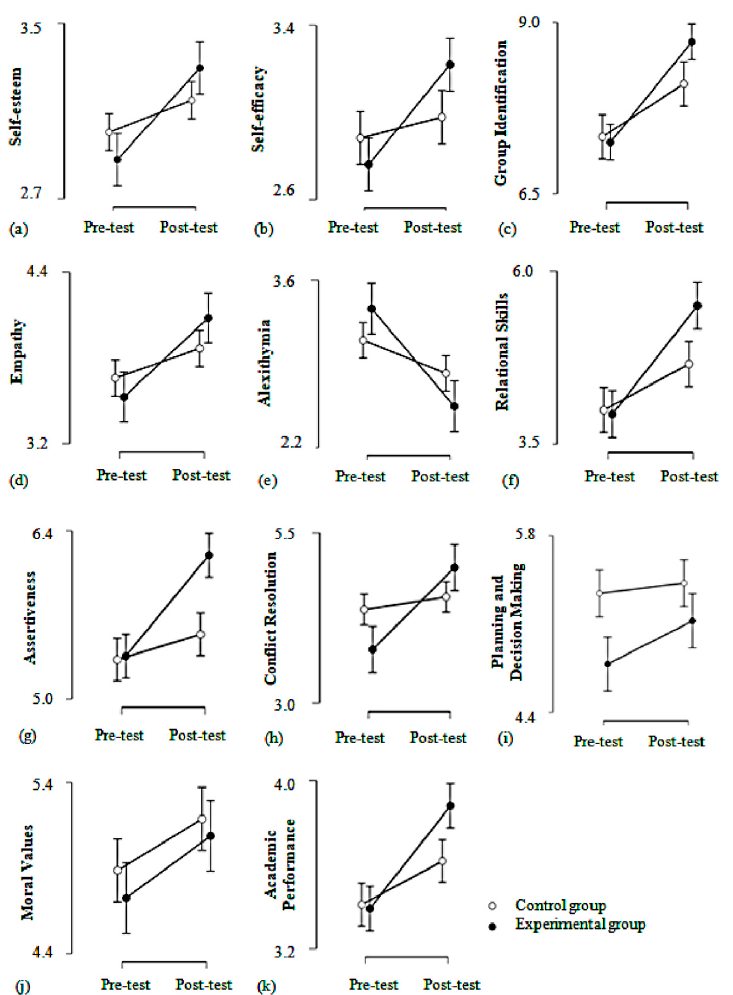
Figure 1. Pre-test and post-test means on PYD variables for intervention and control groups. ( a ) Self-esteem, ( b ) self-efficacy, ( c ) group identification, ( d ) empathy, ( e ) alexithymia, ( f ) relational skills, ( g ) assertiveness, ( h ) conflict resolution, ( i ) planning and decision making, ( j ) moral values, ( k ) academic performance.